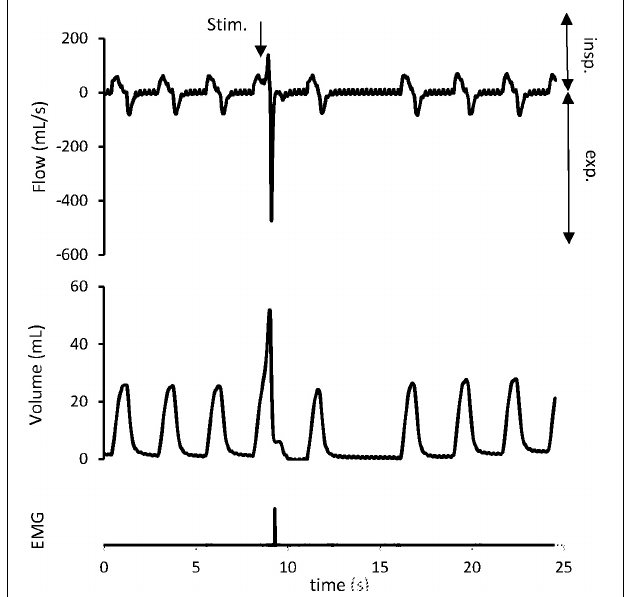
FIGURE 3 | Cough reflex characterized by a concomitant increase in tidal volume (V T ) and peak expiratory flow ( ˙ V E MAX ). The downward arrow indicates tracheal stimulation (Stim.). Positive and negative airflow rates indicate inspiration (insp) and expiration (exp), respectively. Abdominal muscles electromyogram (EMG) also showed activity on the stimulation